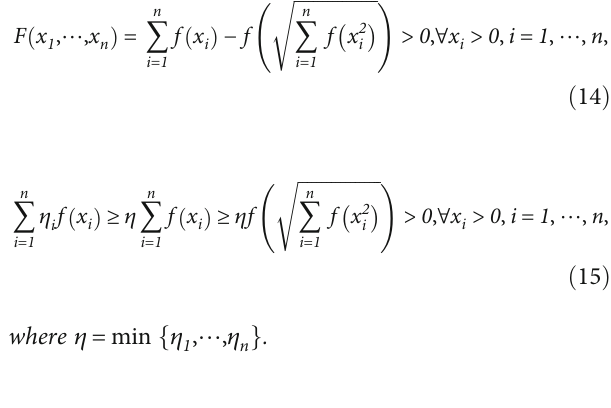
Figure 5: The state error (a) e , (b) _ e , and (c) control output u curves of the second-order system with e performance of η